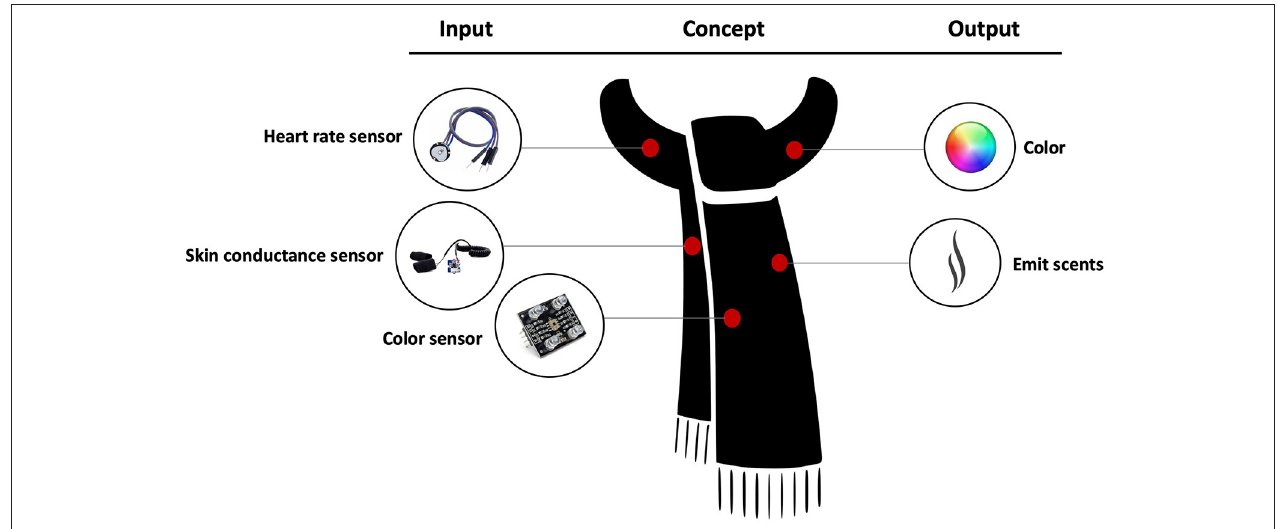
FIGURE 5 | Concept of a smart scarf designed for emotion recognition (91).